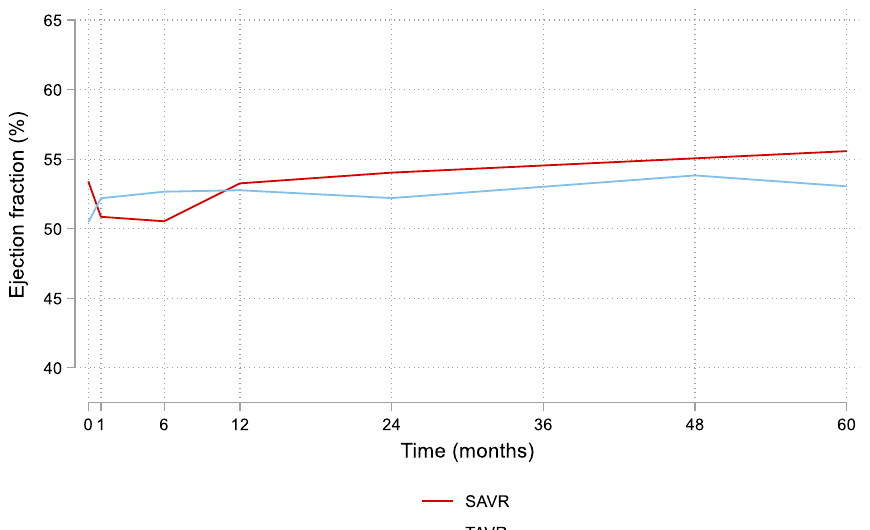
Fig. 3 Change in ejection fraction after SAVR compared to TAVR (SAVR, surgical aortic valve replacement; TAVR, transcatheter aortic valve replacement)